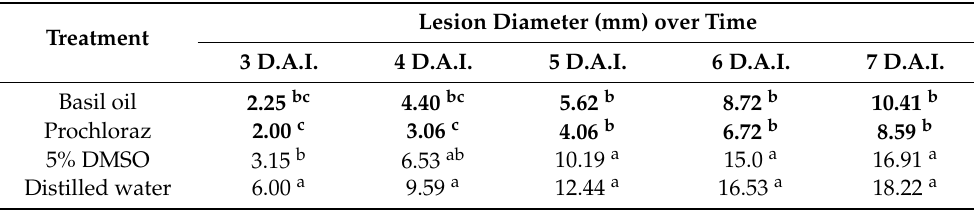
Table 6. Effect of basil oil, fungicide, and control treatment on lesion diameter (mm) of anthracnose on mango fruits caused by C. acutatum over 7 days after inoculation. Treatment